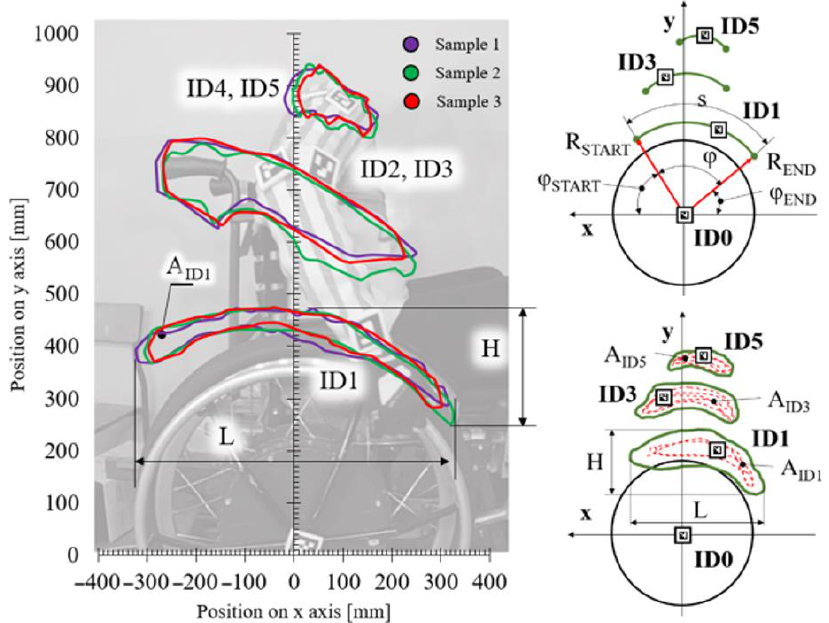
Figure 7. Geometric interpretation of the kinematic parameters of the upper limb segments during measurements with the use of motion capture.